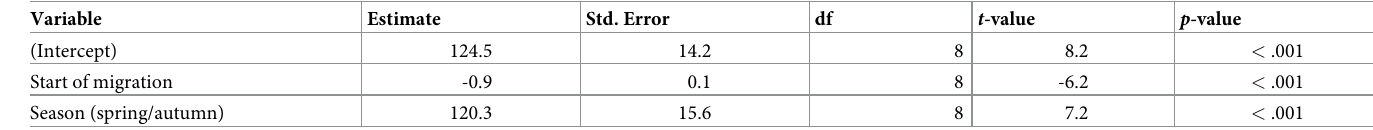
Table 2. Results from a generalised linear mixed model regarding total migration duration. Formula: total migration duration from departure to arrival ~ start date + season + (1|individual).